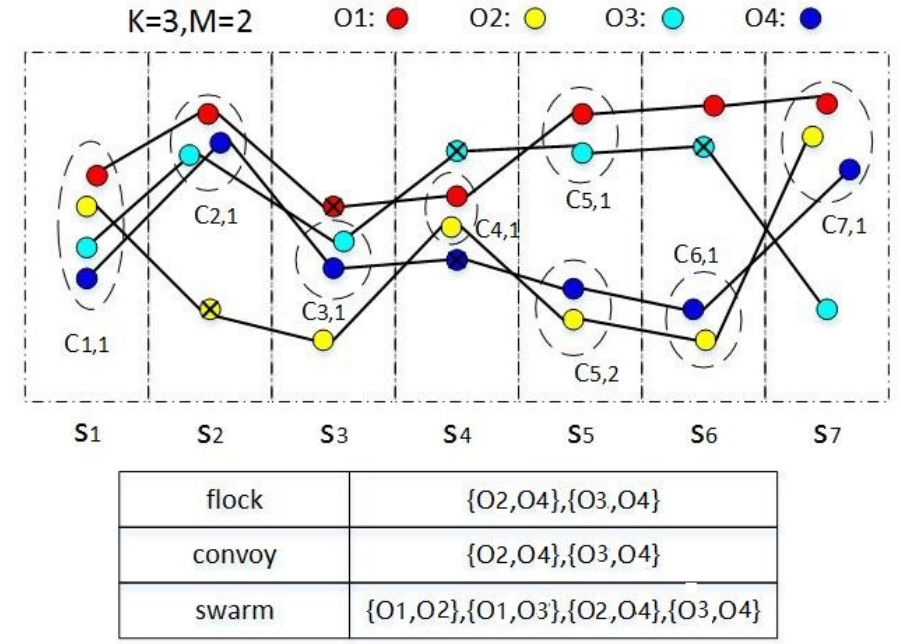
Figure 2. Group movement patterns. The results of different patterns are exhibited in the